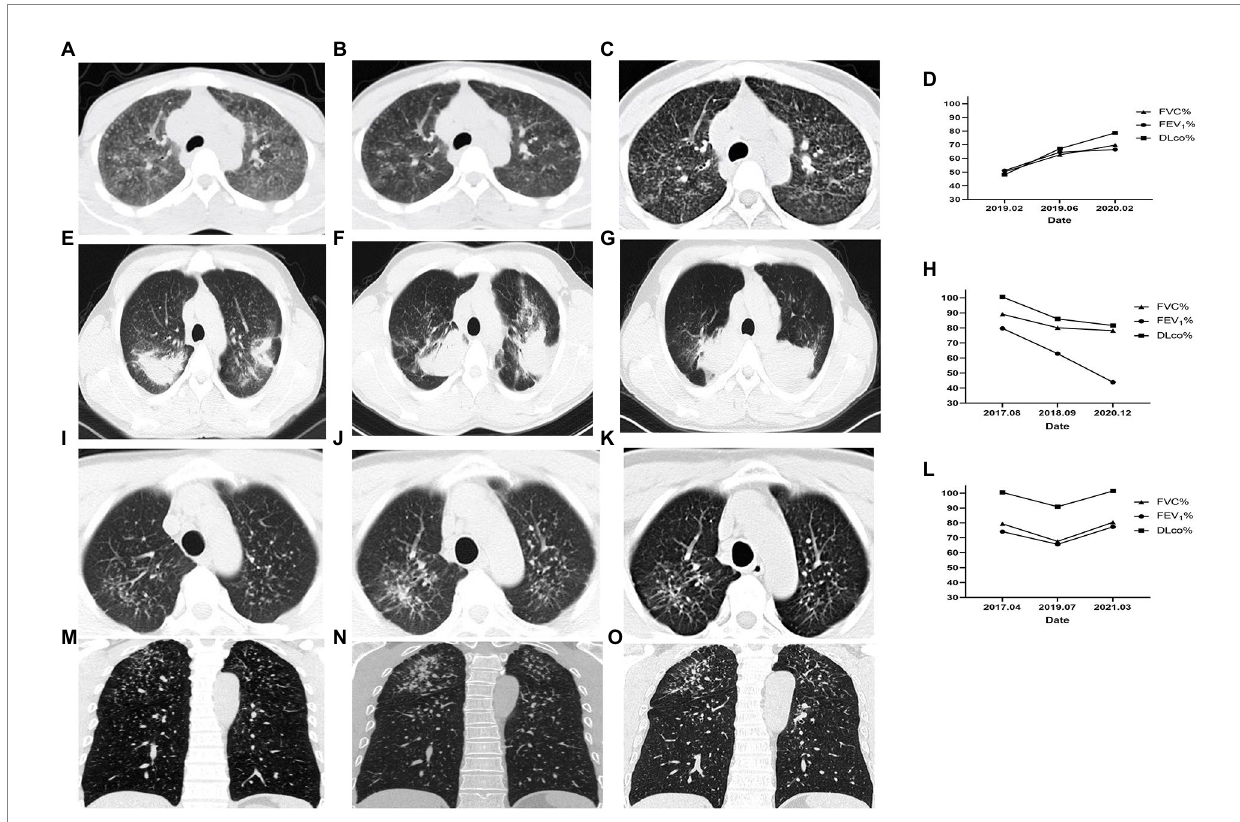
FIGURE 2 Changes of HRCT and pulmonary function of representative cases. Case 1 of the observation group. (A) HRCT showed diffuse GGOs, extensive nodular opacities, and para-aortic lymph node enlargement at baseline. (B) GGOs was significantly reduced after 4 months. (C) GGOs dissipated without coalescence or PMF emerging after 31 months of treatment. (D) The pulmonary function indexes FVC%, FEV 1 %, and DLco% showed an increasing trend. Case 2 of the control group. (E) HRCT showed PMF on bilateral lungs at baseline. (F) The left lung PMF enlarged and the right lung PMF contracted centripetally with emphysema developing 13 months later. (G) The lesion on HRCT continued to progress and the emphysema worsened. (H) Correspondingly, the pulmonary function gradually decreased. Case 3 began Tet treatment after the second HRCT. (I,M) Cross-sectional and coronal HRCT images showed diffusely distributed nodules at baseline. (J,N) Nodule opacities increased and coalescence emerged in the right upper lung 27 months later. (K,O) GGO around the coalescence in the right upper lung dissipated and the coalescence had not progressed after 20 months of Tet treatment. (L) The pulmonary function decreased over 27 months without Tet treatment and increased over 20 months with Tet treatment. This case was included in the observation